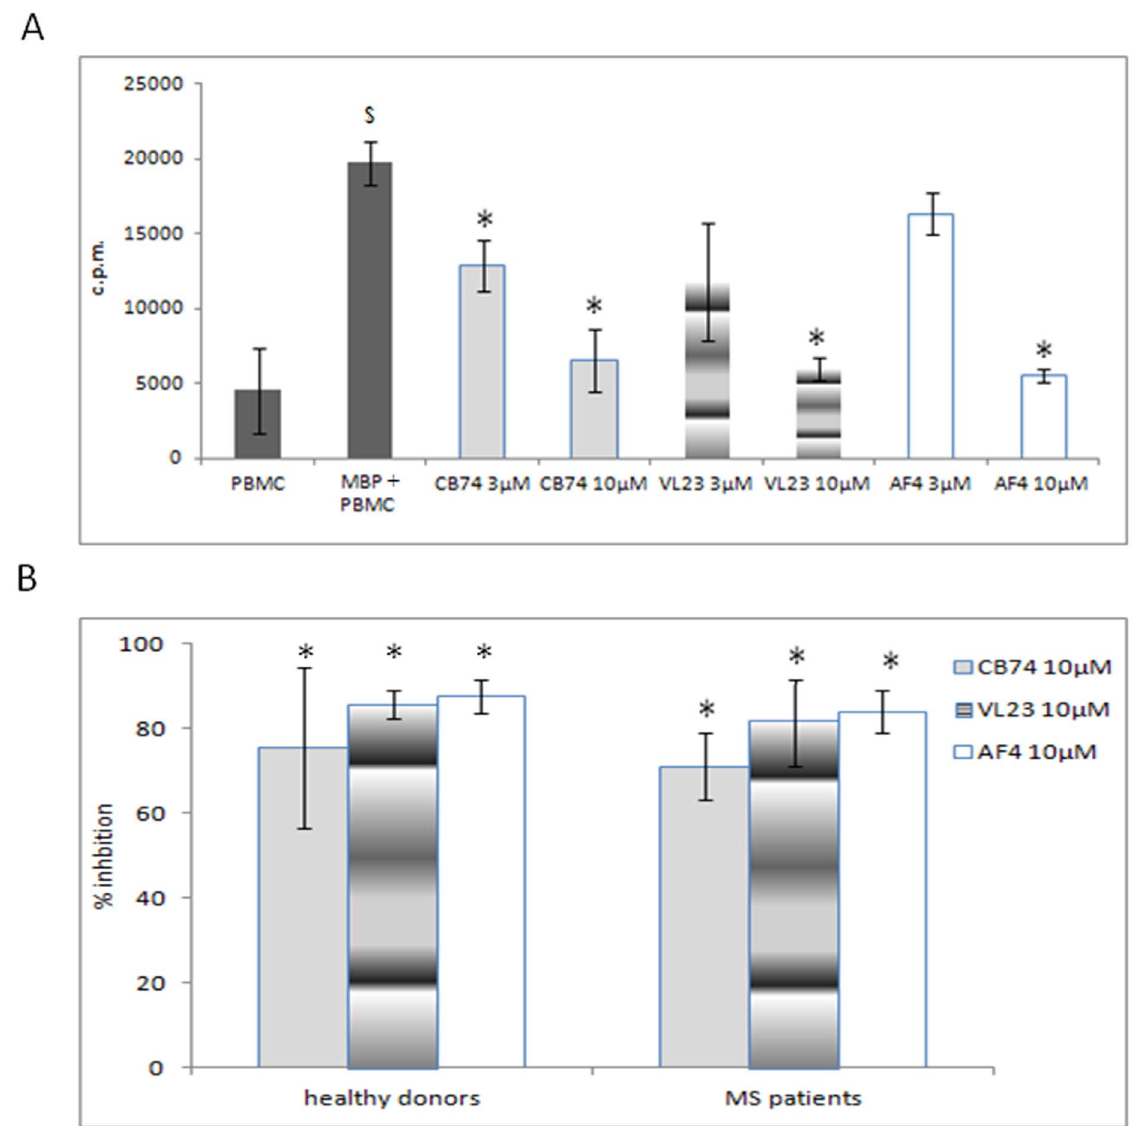
Figure 1. 1,8-naphthyridine, pyridine and quinoline derivatives inhibit proliferation of MBP-activated PBMC. MBP activated PBMC of MS patients (2 6 10 5 cells per well) were treated with the compounds at the indicated concentrations, in triplicate, for 6 days. Proliferation was measured after 1 h of 3 H-thymidine incorporation (1 m Ci). The counts per minutes (c.p.m.) 6 the standard deviation of the triplicates of a representative experiment out of five are shown (A). The activation following MBP stimulation was evaluated with respect to MBP untreated cells, (PBMC in the figure) ( $ p , 0,01). The statistical significance for each compound used at the concentrations of 3 and 10 m M, was calculated with respect to the MBP-activated cells (*p , 0,05, MBP + PBMC in the figure). The histogram B represents the percent of inhibition of cell proliferation calculated with respect to drug untreated and MBP activated cells isolated from MS patients and healthy donors as indicated in the figure (*p , 0,01). The percent of inhibition reported is the mean of five independent experiments and the bars represents the standard deviations.